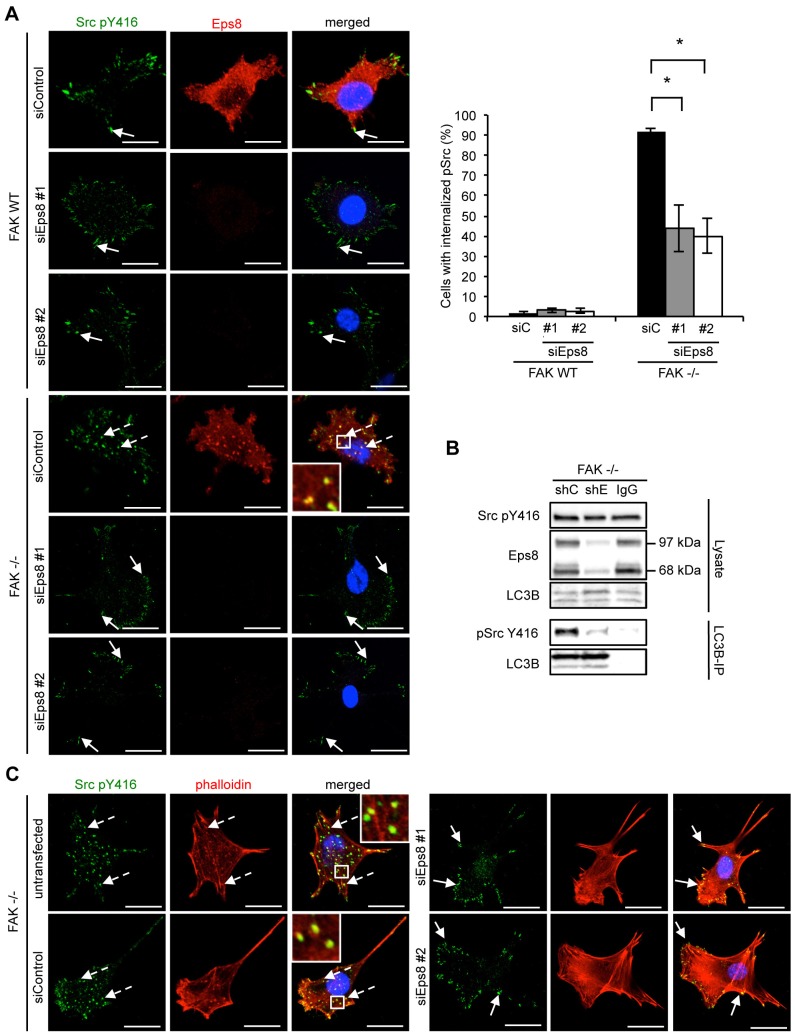
Eps8 is required for active Src localization to autophagosomes. (A) FAK WT and FAK−/− cells were transiently transfected with Eps8 siRNA (siEps8 #1 and #2; siControl, control siRNA), fixed and stained with anti-Eps8 and anti-Src pY416 antibodies. The quantification is representative of three independent experiments. Solid arrows indicate focal adhesions. Dashed arrows indicate active Src in autophagosomes. Scale bars: 20 µm. Results are mean±s.d. *P<0.01 (Student's t-test). (B) FAK−/− SCC cells were infected with either Eps8 (shE) or non-targeting (shC) shRNA and LC3B was immunoprecipitated (IP) from cell lysates. Samples were subjected to western blot analysis using anti-Eps8 and anti-Src pY416 antibodies. (C) FAK−/− cells were transiently transfected with two independent Eps8 siRNAs, fixed and stained with anti-Src pY416 antibody and TRITC–phalloidin. Solid arrows indicate active Src localization at focal adhesions. Dashed arrows indicate active Src in intracellular puncta. Scale bars: 20 µm. Insets show a magnified view of the boxed area.